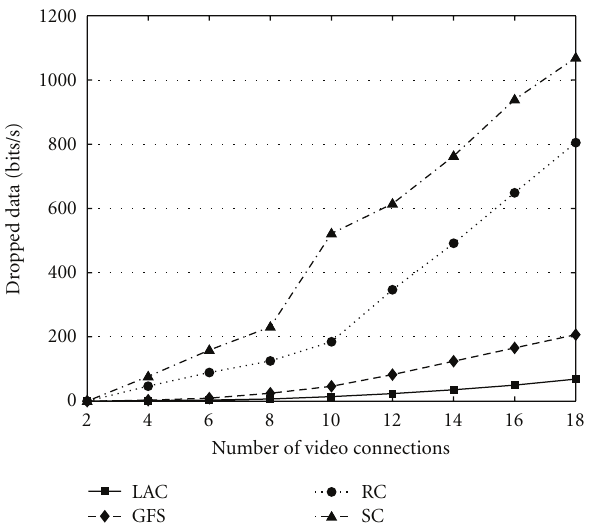
Figure 9: Average dropped data with video tra ffi c.